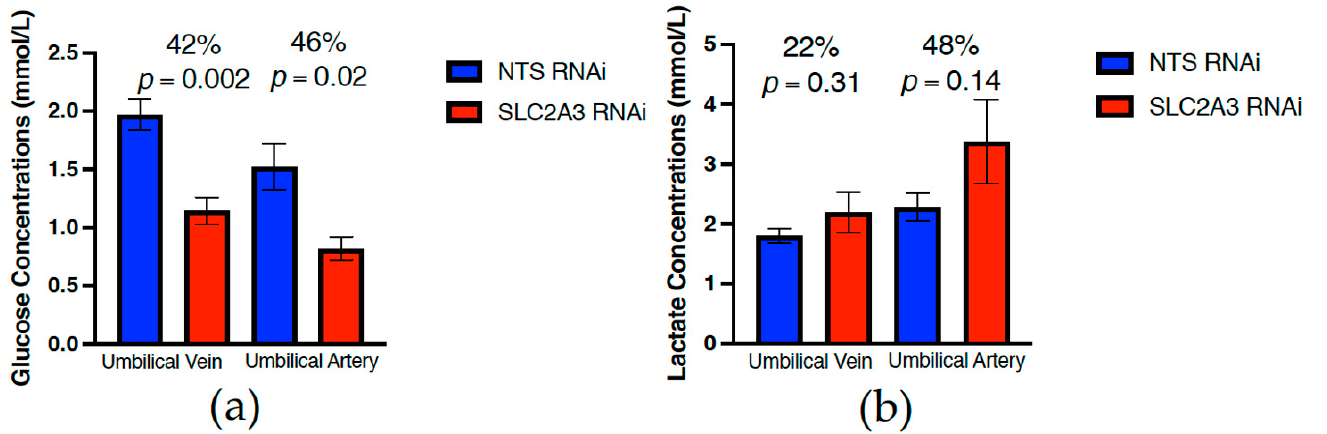
Figure 4. Impact of SLC2A3 RNAi on both umbilical vein and artery concentrations of ( a ) glucose and ( b ) lactate in plasma samples harvested at 75 dGA. Data are shown as means ± SEM. NTS, non-targeting sequence; RNAi, RNA interference. Table 3. Maternal plasma amino acid concentrations (75 dGA).